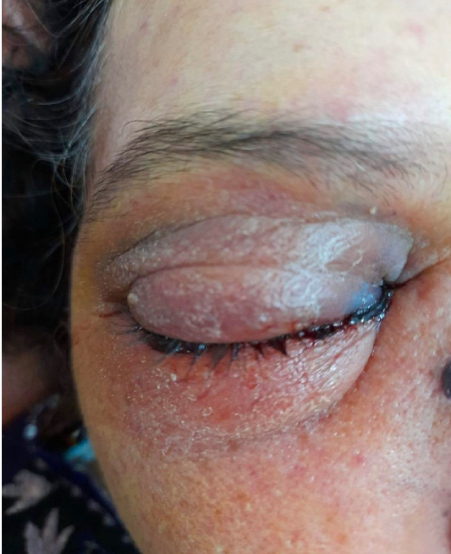
Figure 2. Extra-oral image of the Case No. 2 revealed a swelling around the right